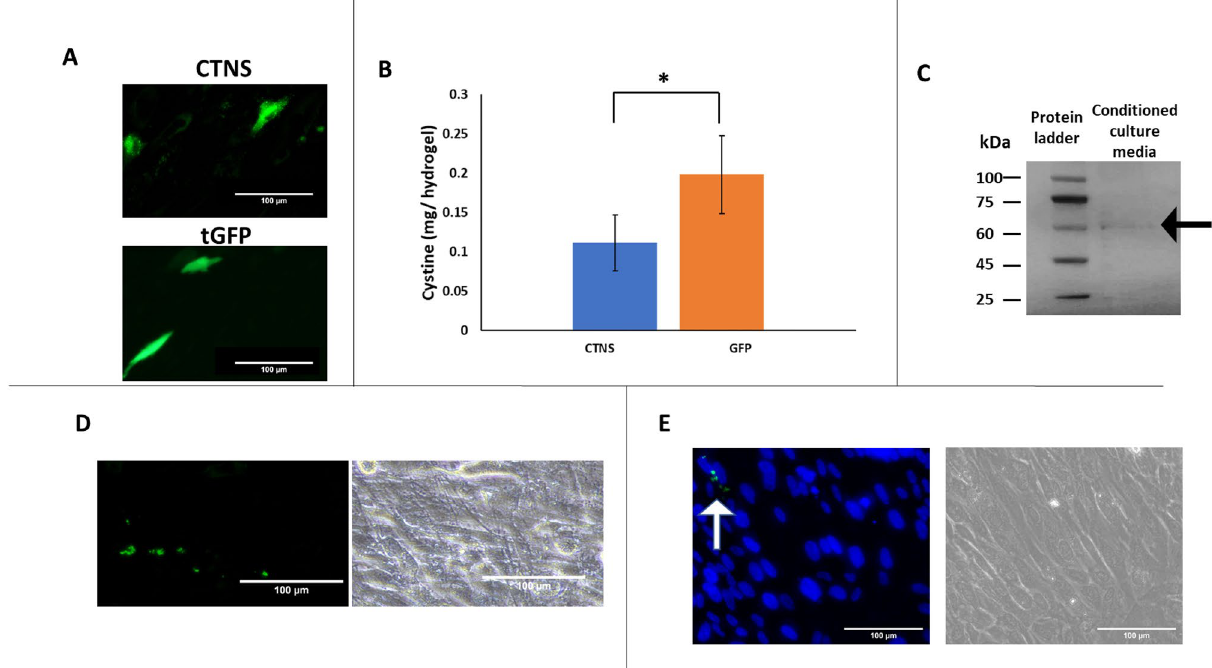
Figure 9. Seeding of cells from a patient with cystinosis on fibrin hydrogels. Cells from a patient with cystinosis were seeded on hydrogels, loaded with either CTNS-encoding plasmid (top), or tGFP empty vector as a control (bottom) ( A ). Two days after, cystine levels were significantly reduced in CTNS group. T-test statistics. * p ≤ 0.05 N = 4 ( B ). TurboGFP-immunoprecipitation of culture media was performed, and secreted CTNS was detected by SDS-PAGE N = 3 ( C ). Non-transfected cells were cultured with conditioned media from the hydrogels. The day after, fluorescence images (on the left), with their corresponding brightfield images (on the right) were taken. Sparse green, fluorescent dots were visible N = 3 ( D ). To confirm intracellular localisation, in some experiments, nuclei of live cells were counterstained with Hoechst 33,258. Fluorescence images (on the left), with their corresponding brightfield images (on the right) were taken. The white arrow indicates the green, fluorescent dots N = 3 ( E